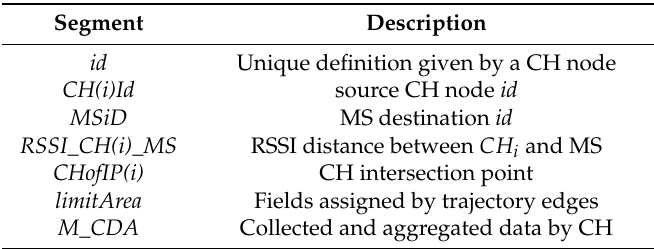
Figure 8. The routing packet format transferred in the network. Table 4. The segment descriptions of the routing packet format.